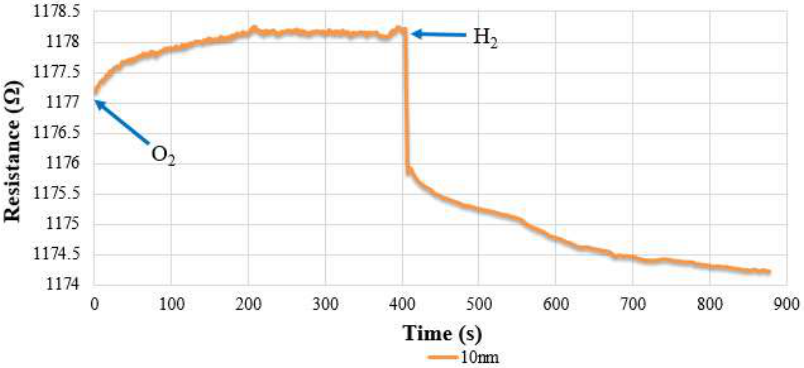
Figure 4. The resistance change of the hydrogen microsensor with hydrogen and oxygen.